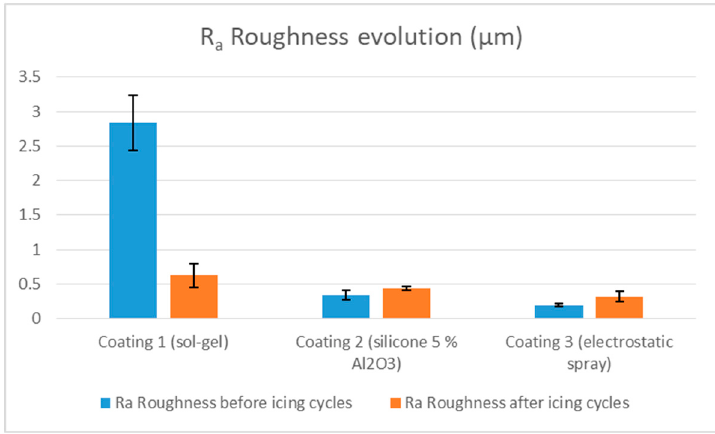
Figure 9. Evolution of the surface roughness before and after the Icing/De-icing cycles.